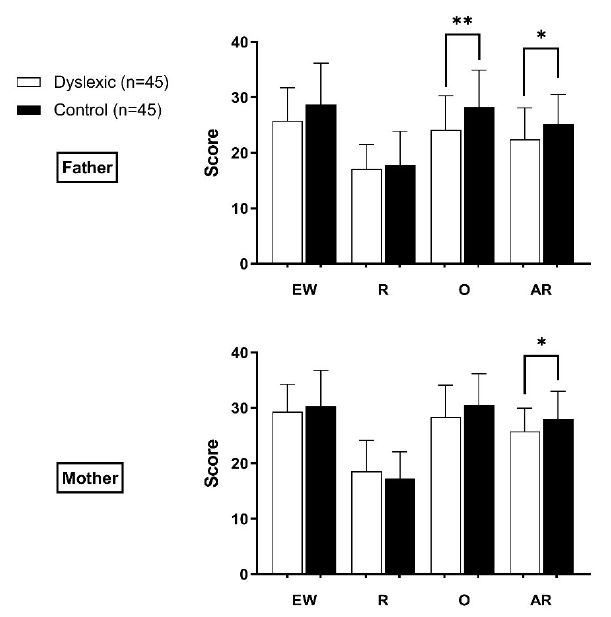
Figure 2. Difference of parental rearing style between dyslexic group and control group. Abbrevia- tions: EW, emotional warmth; R, rejection; O, overprotecting; AR, anxious rearing. Note: * p < 0.05; ** p < 0.01; This part of the data analysis excluded children from a single parent family.